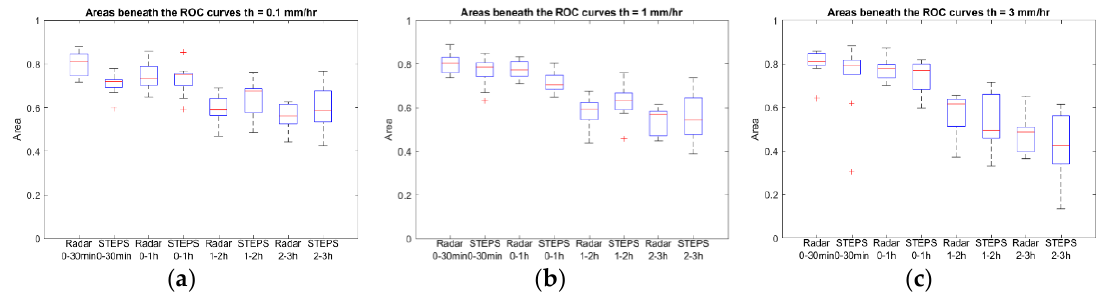
Figure 8. Area beneath ROC curves for all the events using radar ensembles and STEPS ensembles and thresholds 0.1 mm/h ( a ), 1 mm/h ( b ) and 3 mm/h ( c ).